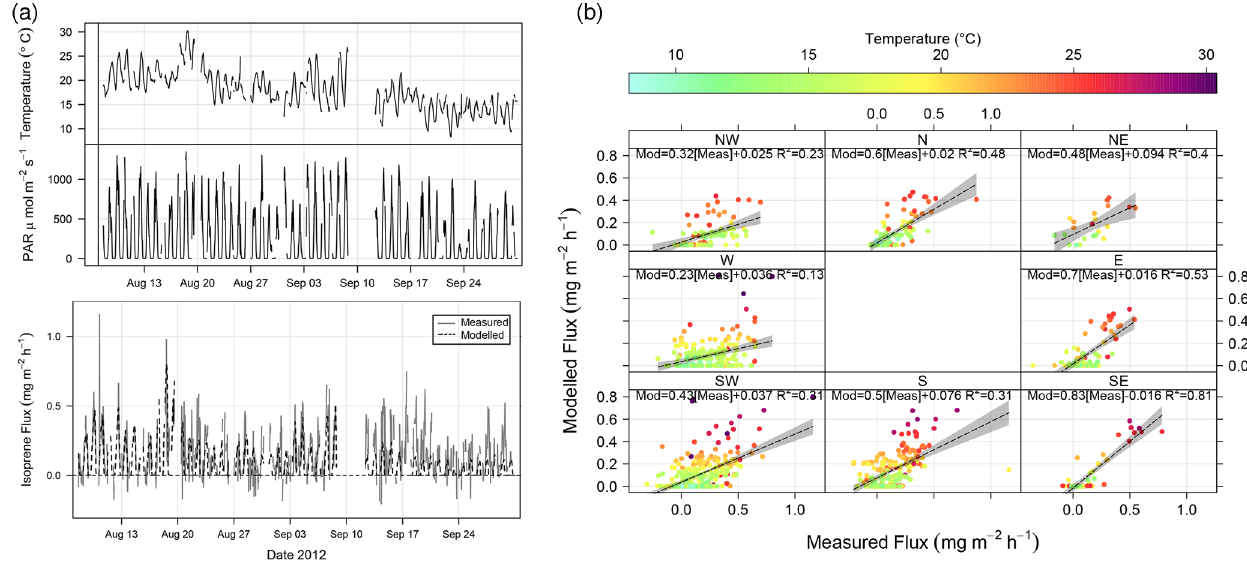
Figure 5. (a) Time series of both measured (grey) and modelled (black) fluxes, as well as PAR and temperature measurements for August and September 2012. (b) Correlation between modelled and measured isoprene fluxes (mgm − 2 h − 1 ) by wind direction using the G95 algorithm with temperature as a third variable, ordinary least squares regression lines, 99th confidence intervals, formulae and R 2